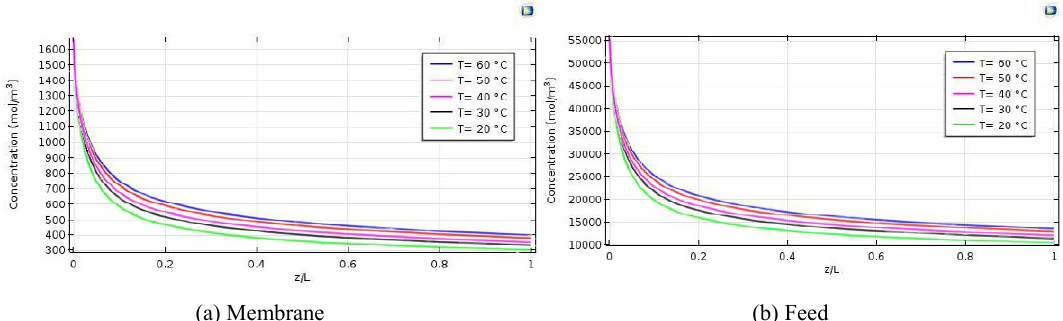
(a) Membrane (b) Feed Fig. 13: Water concentration profile vs. membrane dimensionless length at different temperatures (3 l/min feed flow rate and 1 bar pressure); (a) Membrane section and (b) Feed section